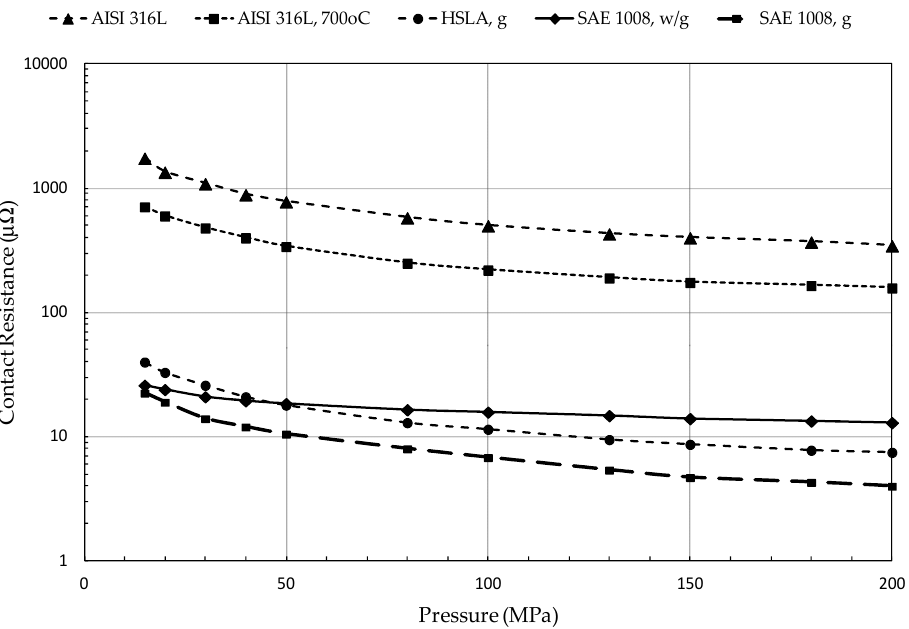
Figure 8. Contact resistance for AISI 316L; HSLA galvanized (g); SAE 1008 without zinc coating (w/g) and SAE 1008 galvanized and AISI 316L at 700 °C. Adapted from [22].